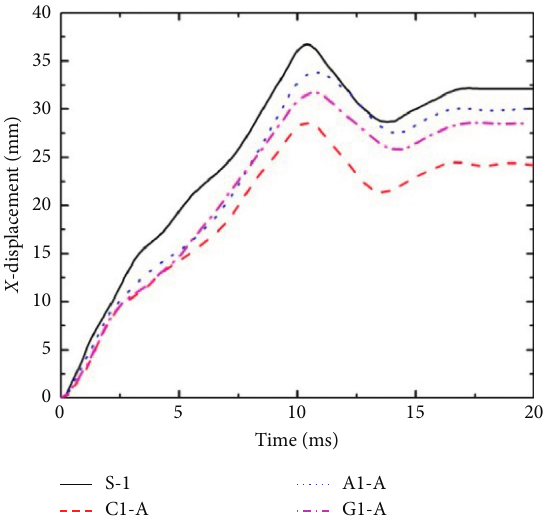
Figure 13: Displacement history curve at midspan of the column retrofitted with different FRP